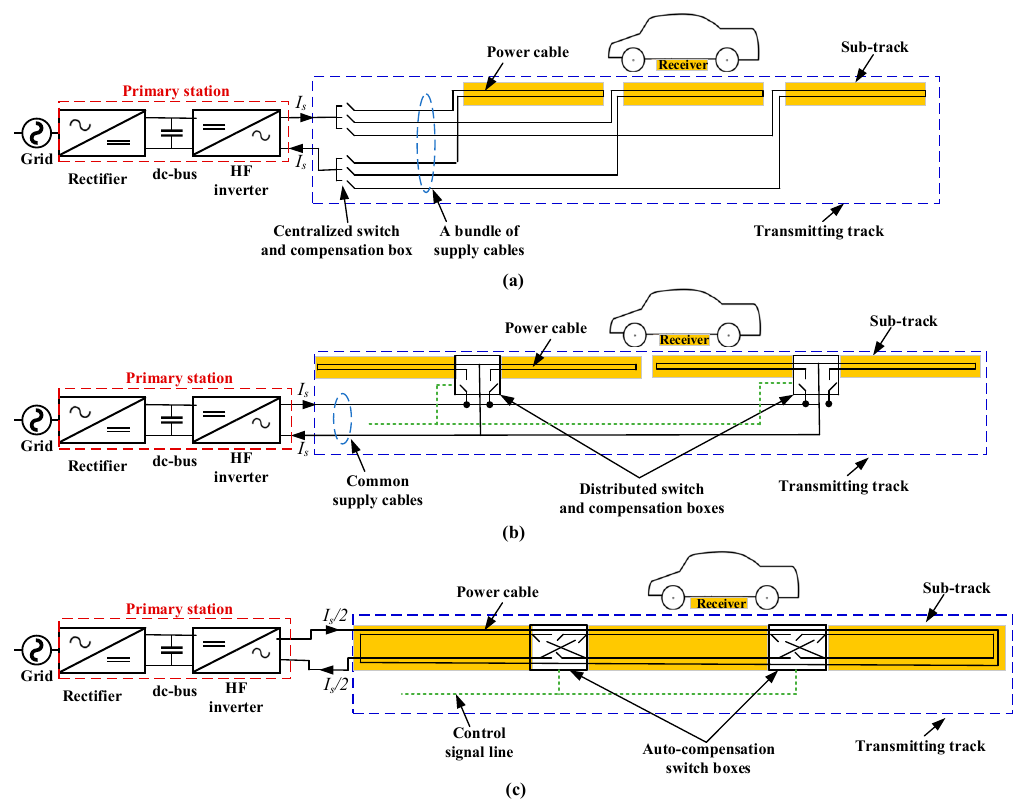
Figure 5. Types of sectionalized long transmitting track: ( a ) centralized switching, ( b ) distributed switching, and ( c ) crossed-segmented switching.